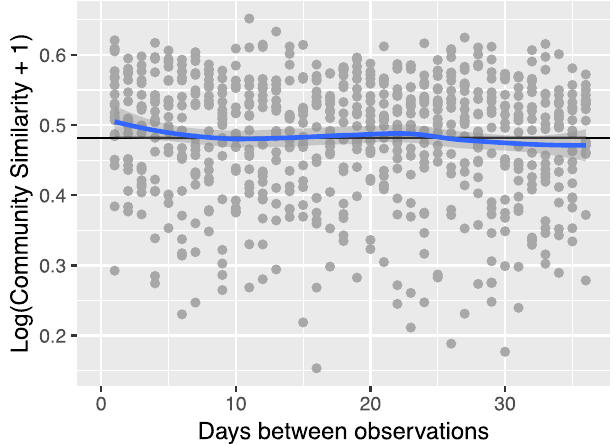
Fig. 5 Longitudinal sampling can be done over the course of several weeks in normal situations without perturbations. There is no similarity decay in microbiota composition over 4 weeks. Linear model of log- transformed similarities ( = 1 - community dissimilarities (BC)) between time points of interpolated QMP time series against the number of days elapsed ( R 2 = 0.013, P > 0.05). Data points of each day were randomly subsampled to the lowest amount of observations for a day. Length of the evaluated time span was limited to include data of all 20 participants at each value (1 – 36